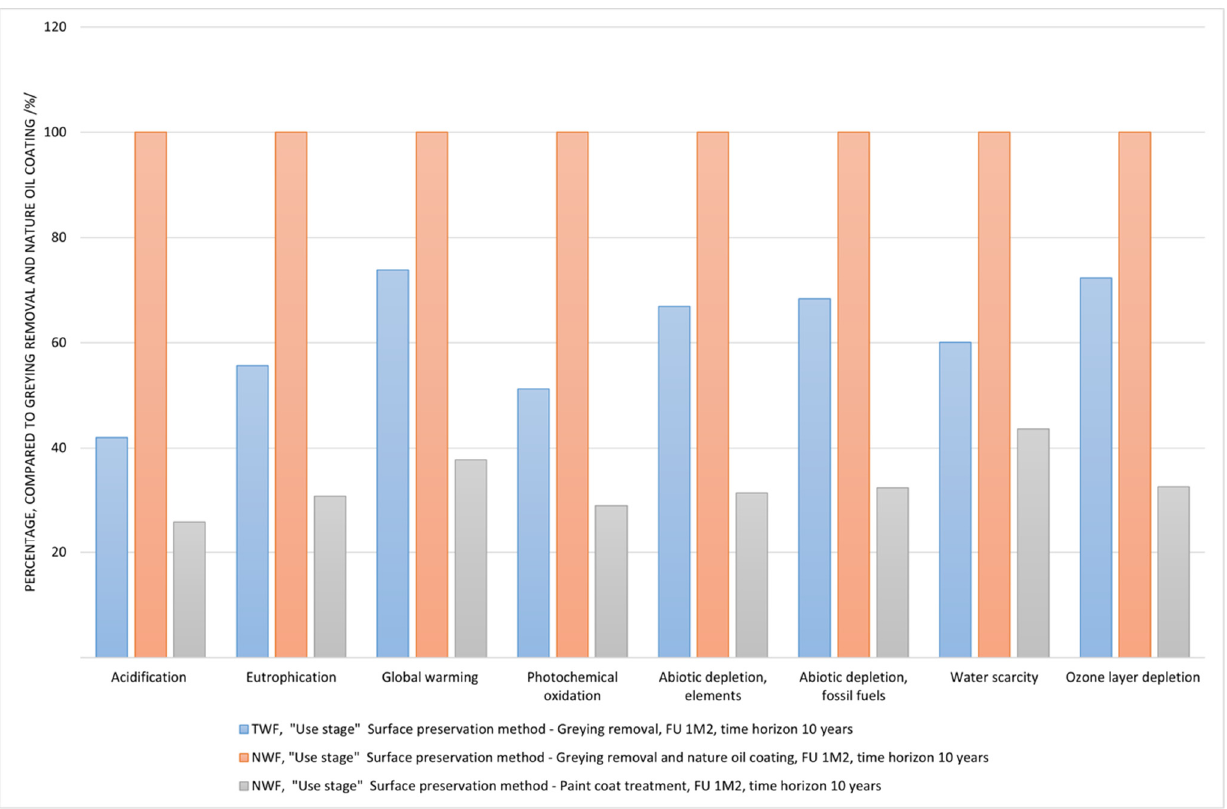
Figure 5. Comparing the “Use stage” for the functional unit (FU) (1 m 2 ) of TWF with selected surface treatments and NWF with selected coatings; time horizon 10 years. Method EPD (2018) V1.01. TWF—thermally modified wood façade, NWF—non-heat-treated wood façade.